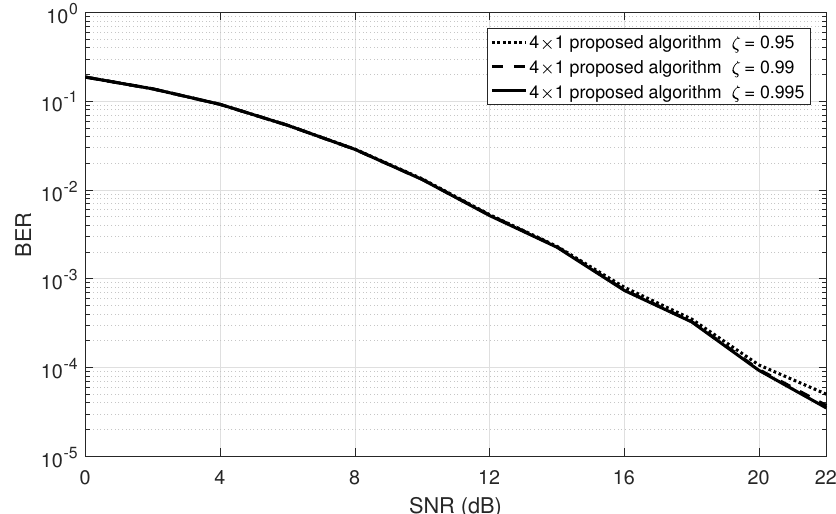
Figure 1. BER performance of the proposed algorithm at various forgetting factors for the four antennas system in a Rayleigh fading channel.